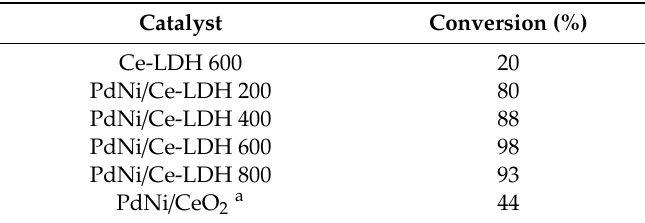
Table 5. BPE conversions for the di ff erent PdNi catalysts as determined through HPLC. Reaction